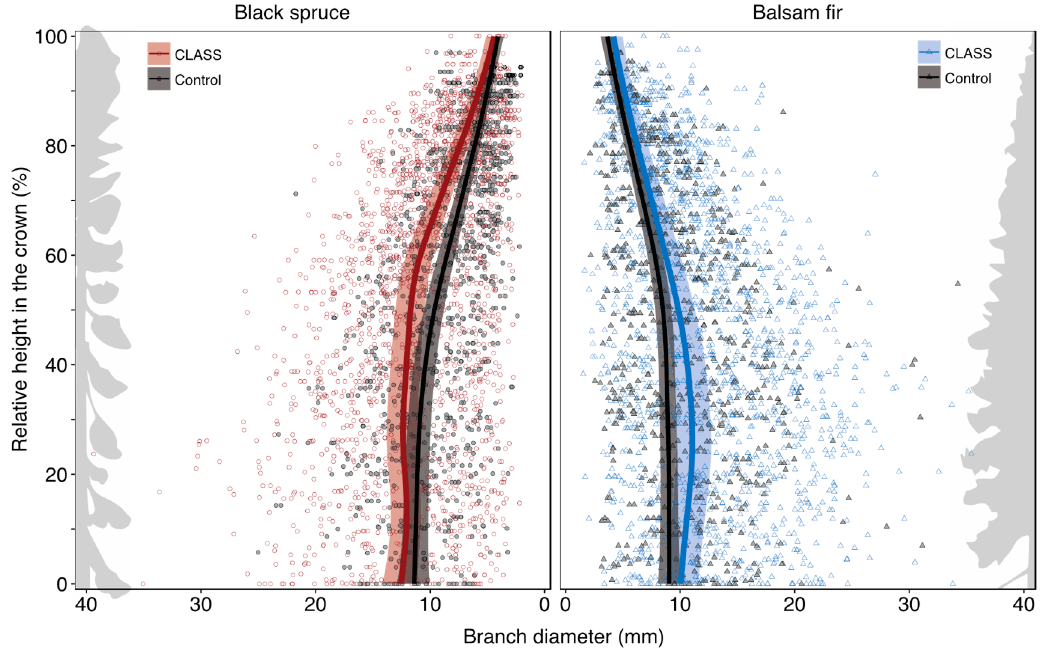
Figure 6. Conditional plot of the effect of relative branch height in the crown on branch diameter for all the control and treated trees of black spruce and balsam fir obtained from the generalized additive model (GAM) when all other predictor variables are held fixed at their median value. Diameter of all branches measured along the live crown are superimposed. Shaded bands represent the 95% confidence interval.